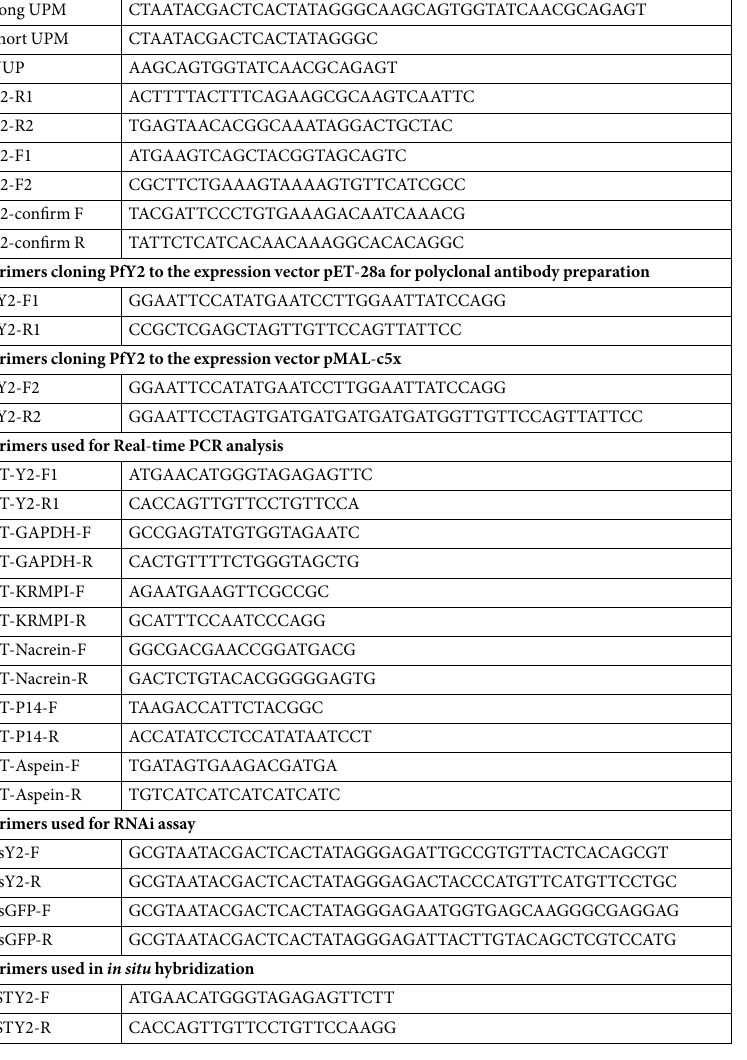
Table 1. Primers used in this study. Abbreviation: F, forward; R, reverse; RT, Real-time qPCR; ds, double strand; IST, in situ